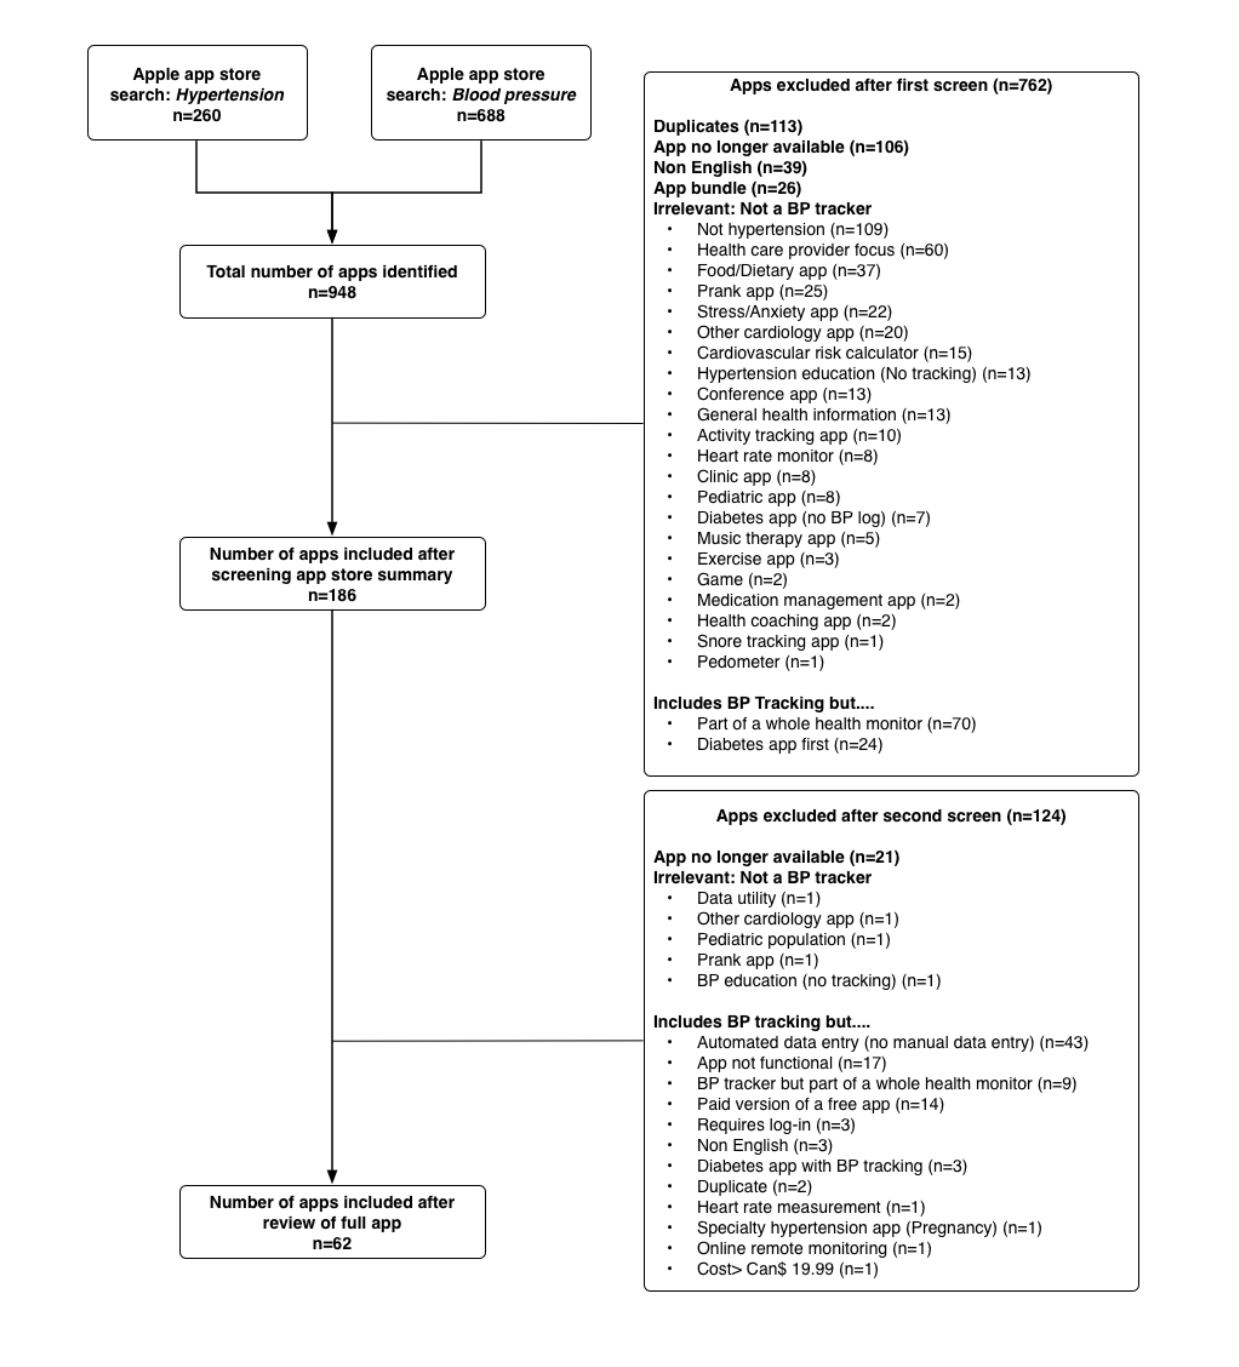
Figure 1. Flow diagram. BP: blood